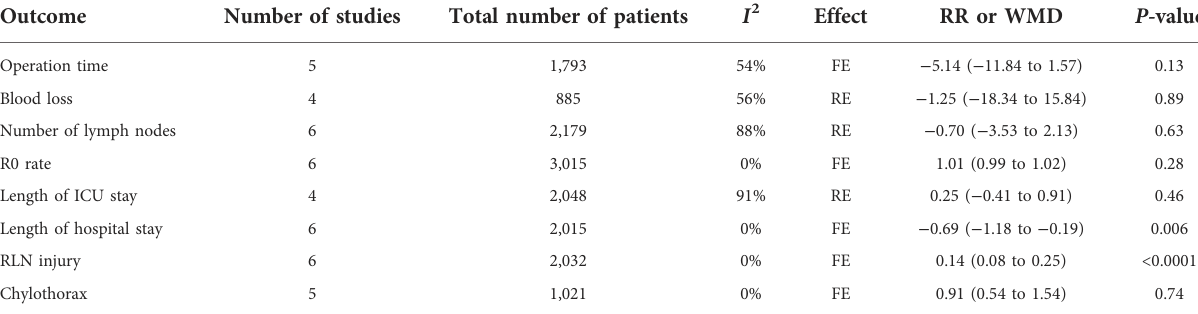
TABLE 2 Secondary outcomes.